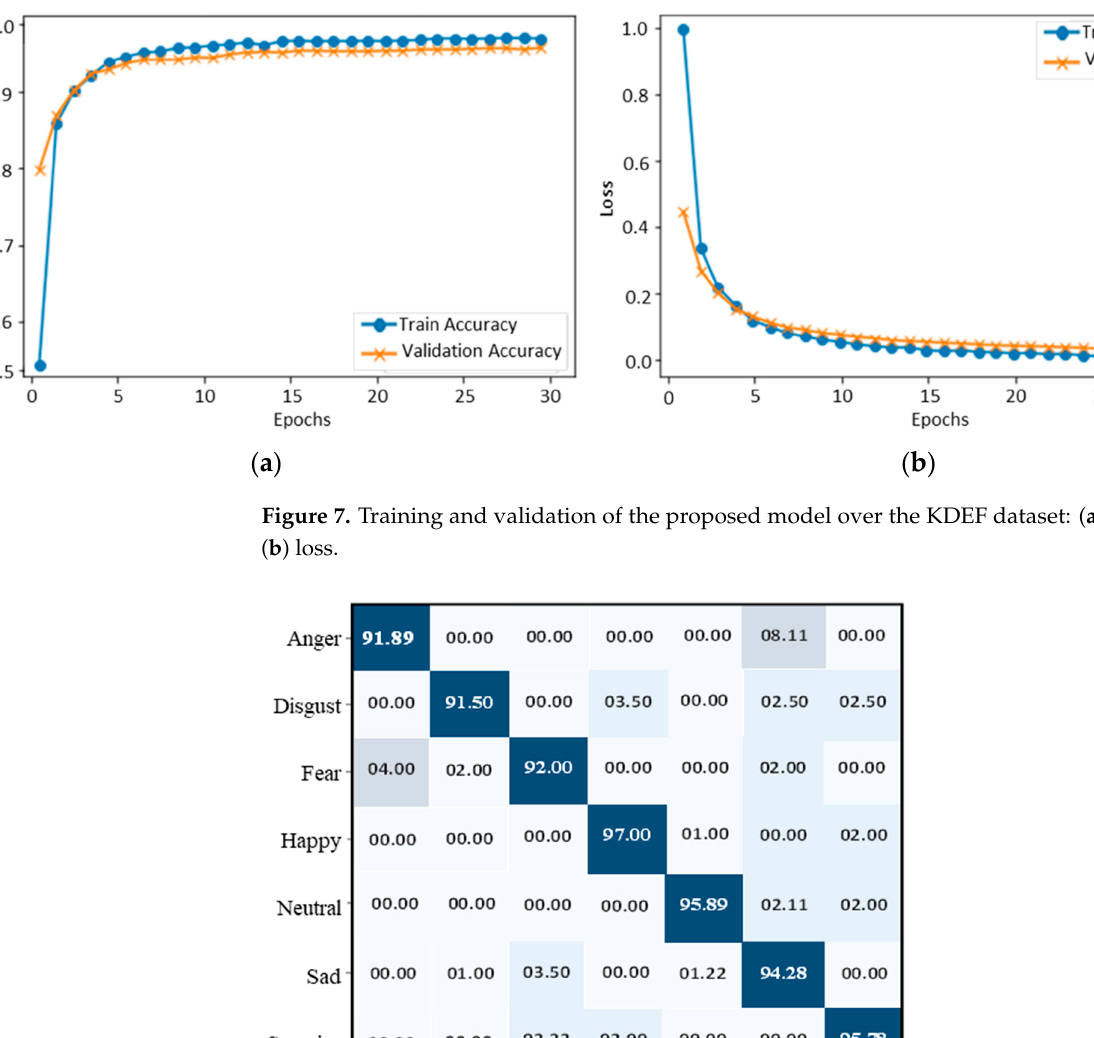
Figure 8. Confusion matrix of the proposed model over the KDEF dataset.